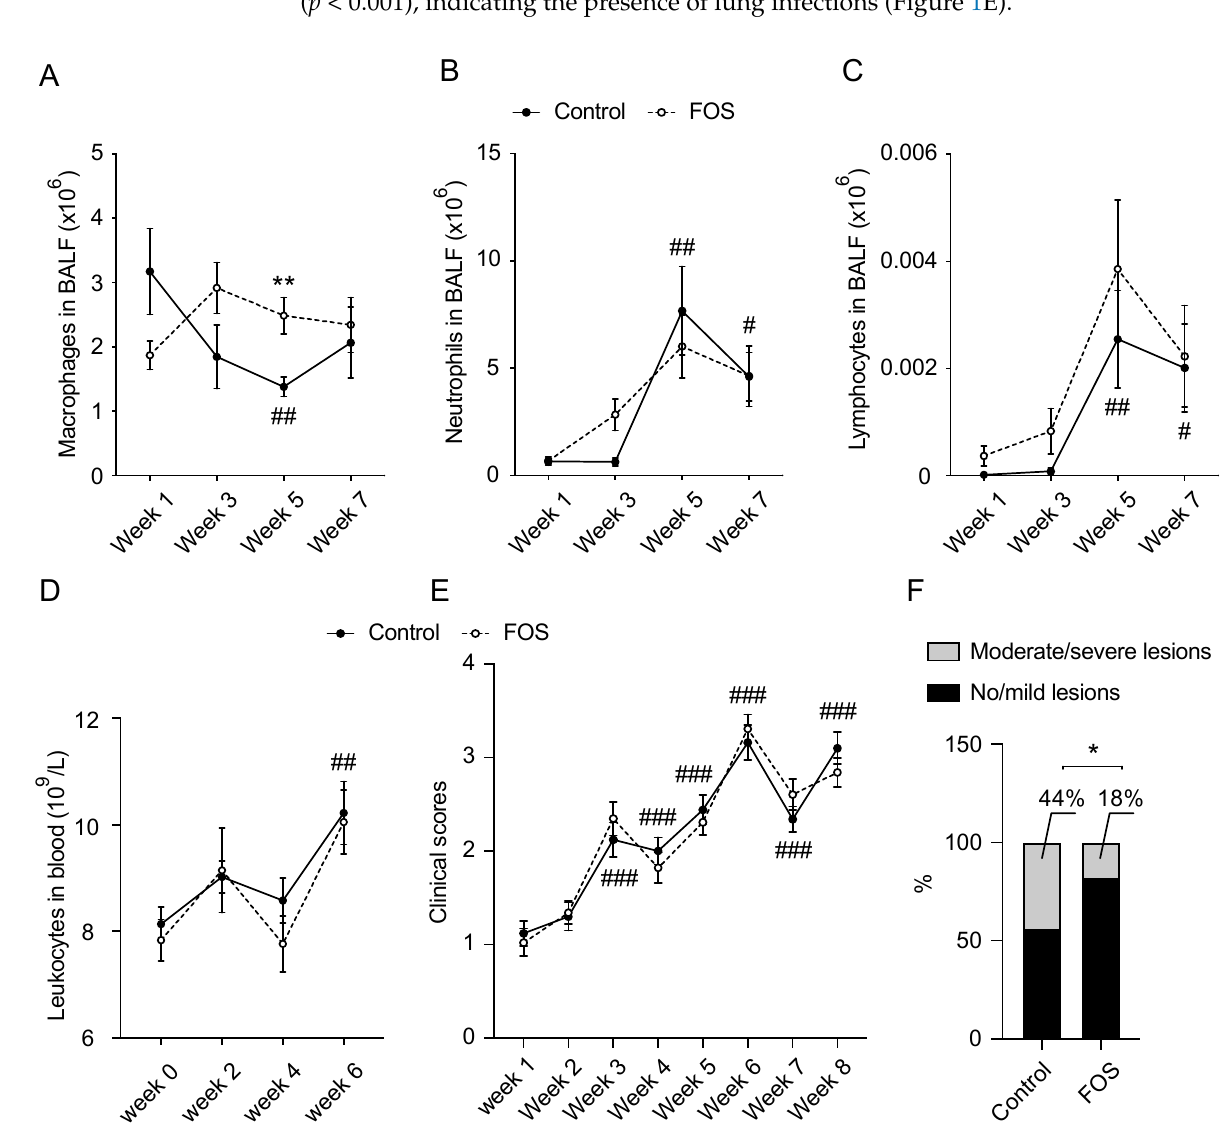
Figure 1. Effect of FOS on BALF and blood cell compositions and clinical and lung scores in calves. Numbers of ( A ) macrophages, ( B ) neutrophils, and ( C ) lymphocytes in BALF and ( D ) leukocyte concentrations in blood were analyzed for a subset of calves ( n = 40, 20 calves/treatment). ( E ) Clinical scores and ( F ) proportion of different lung lesions at slaughter were evaluated for all calves ( n = 100, 50 calves/treatment). Significantly different from week 0 or 1 for control: # p < 0.05; ## p < 0.01; ### p < 0.001. Significantly different from control at that time: * p < 0.05; ** p < 0.01. Data are presented as means ± SEM unless otherwise indicated. Data are presented as percentage for panel F. BALF, bronchoalveolar lavage fluid; FOS,